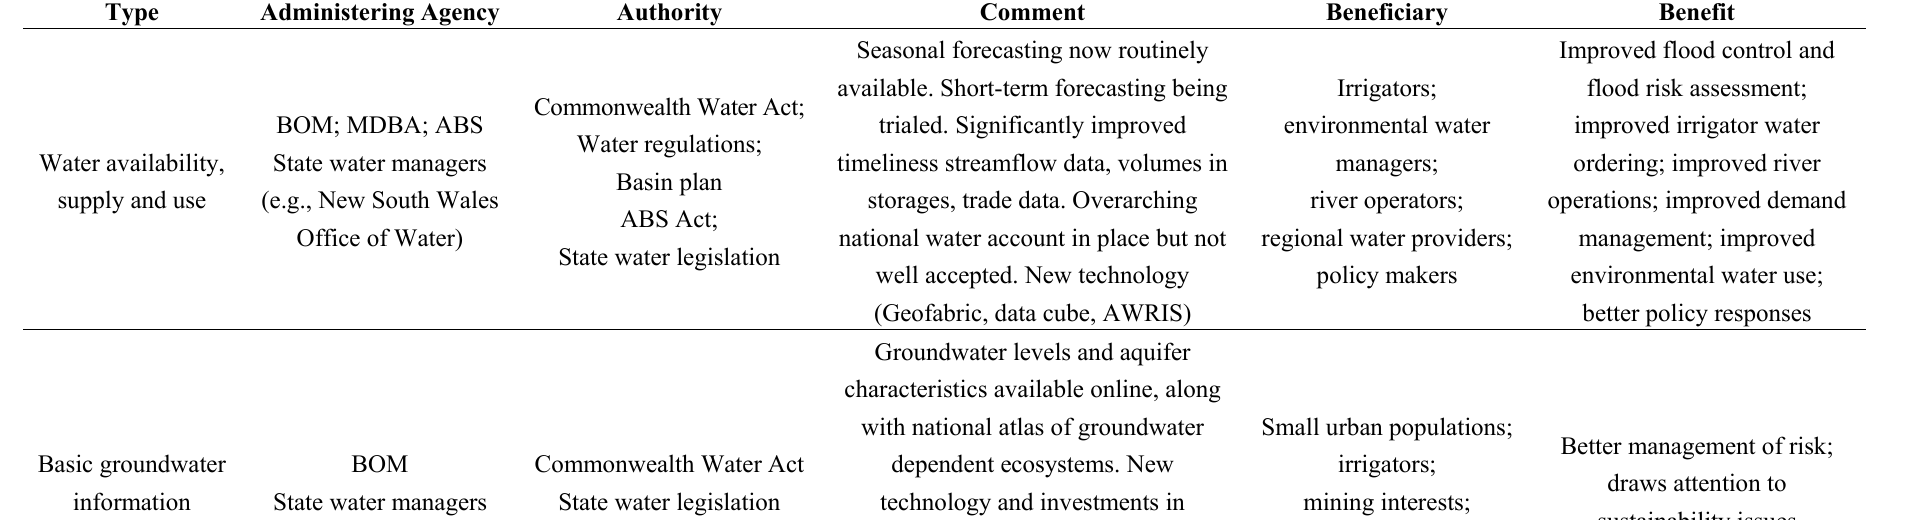
Table 1. Water Information for Sustainable Water Management—Progress in Rural and Regional Australia since